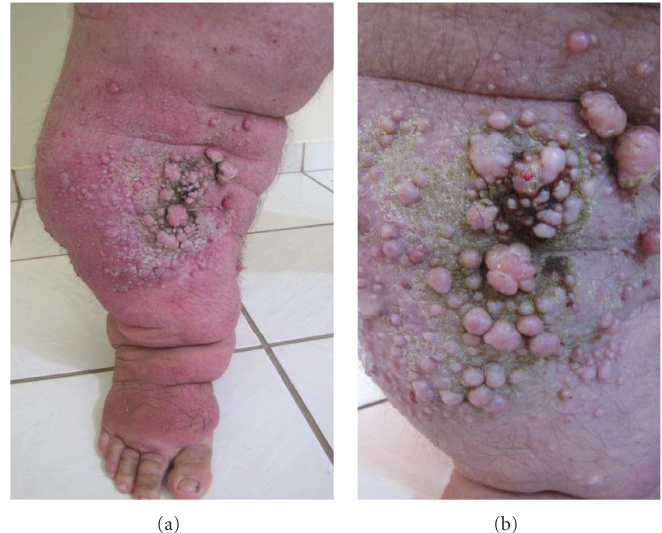
Figure 1: (a), (b) Dermal lesions and lymphorrhea (before treatment).